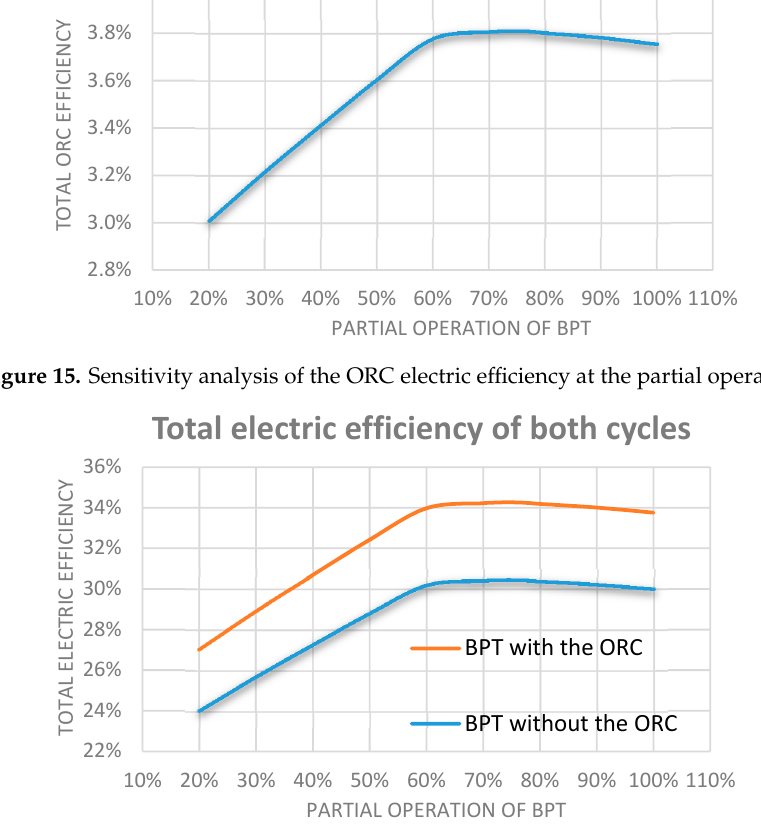
ffi ciency for two cases with and without the Figure 16. Sensitivity analysis of the BPT electric efficiency for two cases with and without the ORC. Figure 16. Sensitivity analysis of the BPT electric e